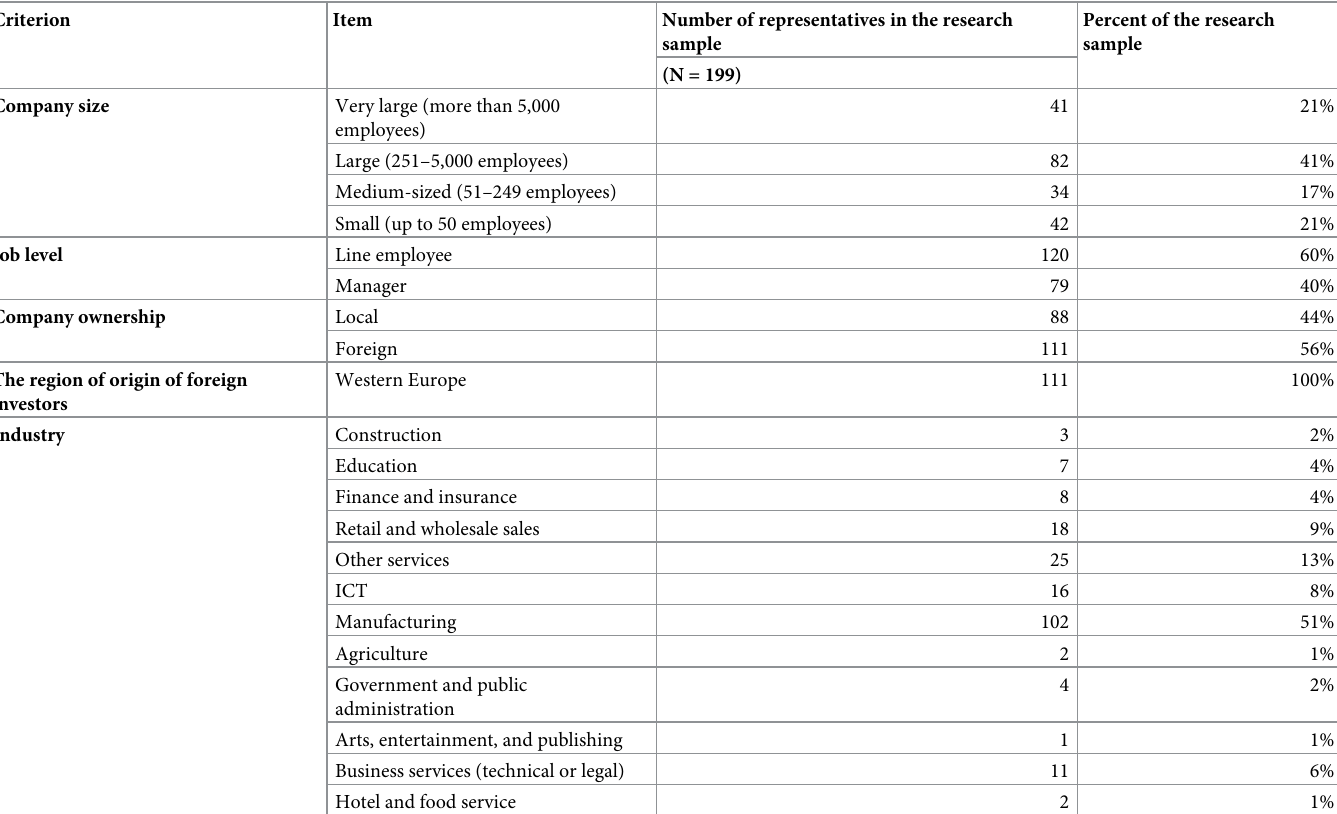
Table 2. Characteristics of the research sample.